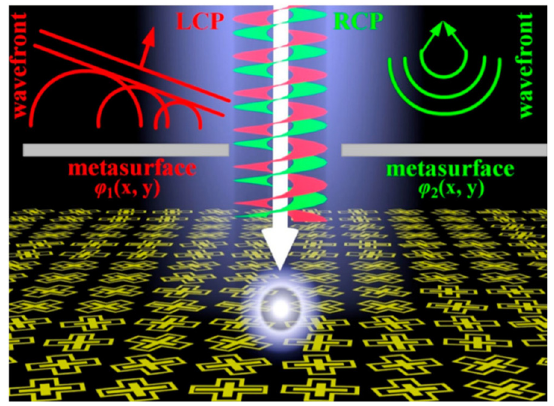
Figure 17: (Reprinted with permission from Ref. [110]). Scattering of a wave impinging on the interface under an arbitrary angle ( θ a ) , withconventionalFresneltransmissionandre fl ectionforthecaseof the bare interface (left) and with re fl ectionless (Brewster) transmissionwhenaproperlydesignedmetasurfaceisplacedatthe interface (right).